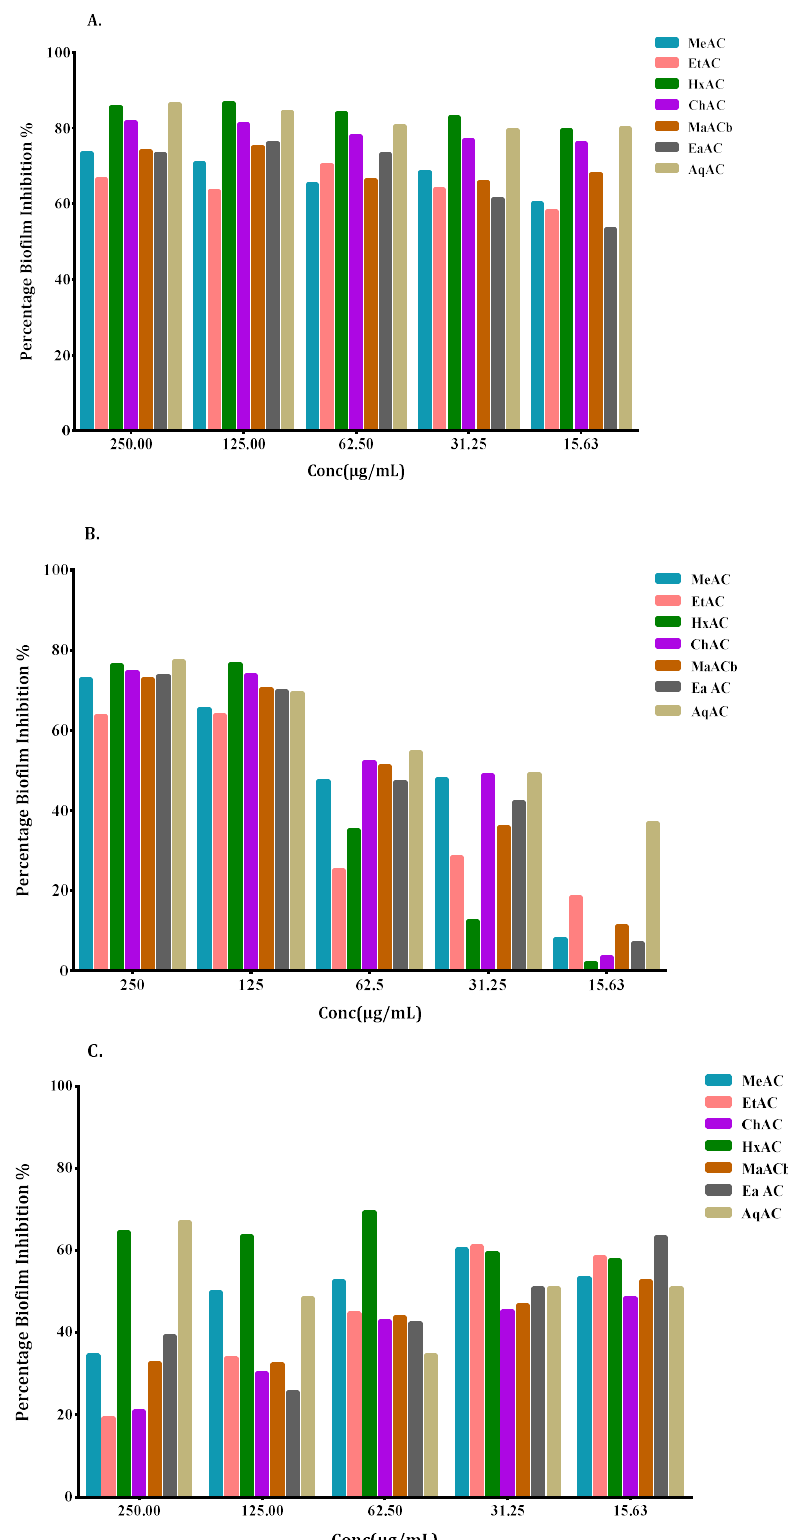
Figure 6. Effects of A. cepa extracts on biofilm formation in ( A ) M. smegmatis ( B ) P. aeruginosa ( C ) S. aureus strains expressed as percentage (%) inhibition and evaluated by the crystal violet staining assay. Values are the average of at least three independent determinations. Extracts of A. cepa pink: MeAC-methanol, EtAC-ethanol, HxAC-hexane and ChAC-chloroform; Allium cepa white: MeACb-methanol, EaAC-ethanol, AqAC-aqueous, CPZ-chlorpromazine; VP-verapamil; CNT-control.